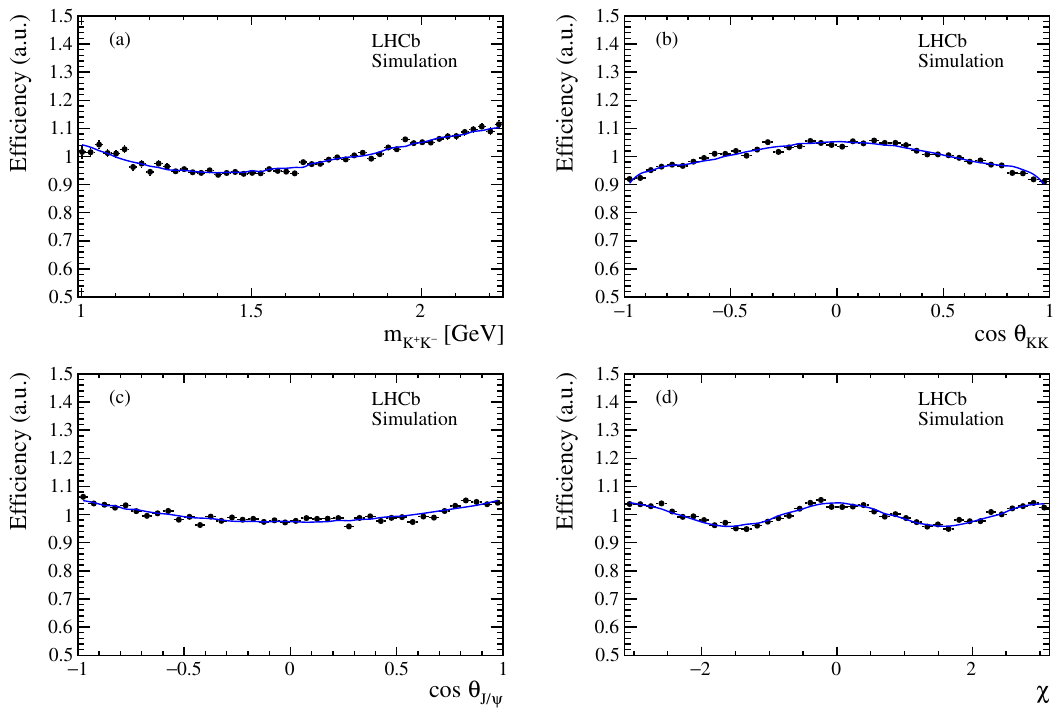
Figure 5 . E(cid:14)ciencies projected onto (a) m KK , (b) cos (cid:18) KK , (c) cos (cid:18) units (a.u.), obtained from simulation of B 0 bars), while the curves show the parameterization from the e(cid:14)ciency